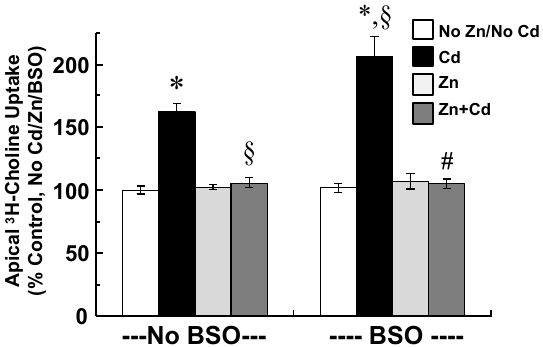
Figure 7. Effects of inhibition of glutathione (GSH) synthesis by L -buthionine sulfoximine (BSO) and zinc supplementation on apical uptake of 10 µM [ 3 H]choline in choroid plexus epithelial cells (CPECs) exposed for 12 h to 500 nM CdcCl 2 . CPECs were first incubated (48 h) in maintenance medium without zinc; i.e., non-supplemented cells, or with 25 µM ZnCl 2 ; i.e., Zn-supplemented cells. In the absence of BSO (--No BSO--), a group of non-supplemented cells was pre-treated (12 h) in serum-free medium (SFM) and then divided into two sets; one set was incubated (12 h) in SFM without cadmium (No Cd/No Zn), while the other was exposed (12 h) to 500 nM CdCl 2 in SFM (Cd). In absence of BSO as well (--No BSO--), a group of Zn-supplemented cells was pre-treated (12 h) in SFM with 10 µM ZnCl 2 and then divided into two sets: one set was incubated (12 h) in SFM with 10 µM ZnCl 2 (Zn), while the other was exposed (12 h) to 500 nM CdCl 2 in SFM with 10 µM ZnCl 2 (Zn + Cd). To test the effects of GSH inhibition, BSO was added to the SFM used for pre-treatment and cadmium exposure of CPECs. In the presence of BSO (--BSO--): a group of non-supplemented cells was pre-treated (12 h) in SFM with 100 µM BSO and divided into two sets: one set was incubated (12 h) in SFM with 100 µM BSO (BSO, No Cd/No Zn), while the other was exposed (12 h) to 500 nM CdCl 2 in SFM with 100 µM BSO (BSO + Cd). In the presence of BSO as well (--BSO--), a group of Zn-supplemented cells was pre-treated (12 h) in SFM with 100 µM BSO and 10 µM ZnCl 2 and then divided into two sets: one was incubated (12 h) with 100 µM BSO and 10 µM ZnCl 2 (BSO + Zn), while the other was exposed (12 h) to 500 nM CdCl 2 in SFM with 100 µM BSO and 10 µM ZnCl 2 (BSO + Zn + Cd). All treatments were performed at 37 °C. After experimental treatments, cells were rinsed and incubated (30 min, 37 °C) in artificial CSF (10 mM Tris-HEPES, pH 7.4) with 10 µM [ 3 H]choline chloride ± 750 µM hemicholinium-3. Artificial CSF did not contain BSO, zinc, or cadmium. Uptake was measured in triplicate in three different culture preparations ( n = 3). Uptake was expressed as percentage of that in control; data are means ± SE; n = 3. * p < 0.05 vs. Control; § p < 0.05 vs. Cd; # p < 0.05 Zn + BSO + Cd vs. BSO + Cd.